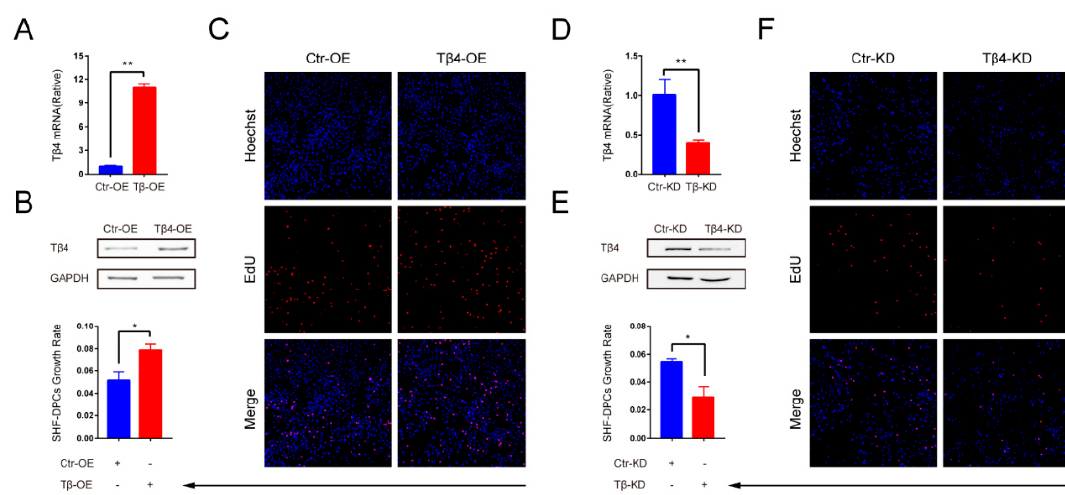
Figure 4. The growth rate of SHF-DPCs was investigated by transfecting T β 4 overexpression (T β 4-OE) or T β 4 knockdown (T β 4-KD) vector. ( A ) qPCR and ( B ) Western blot were used to verify the